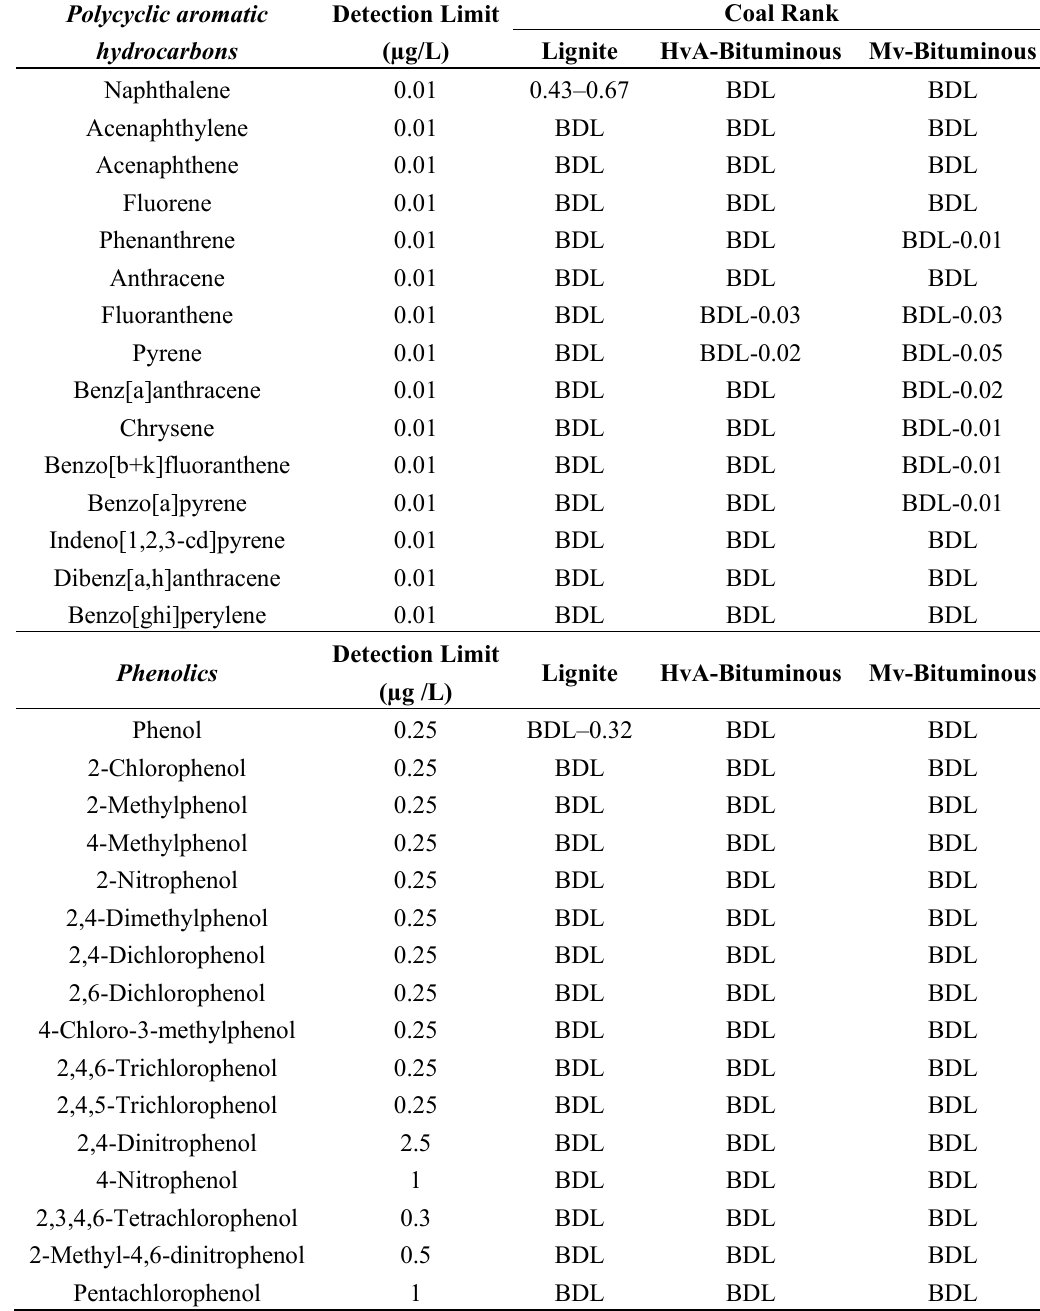
Table 4. Concentration ranges of selected organics from toxicity characteristic leaching procedure (TCLP) experiments performed with deionized water. BDL = below detection